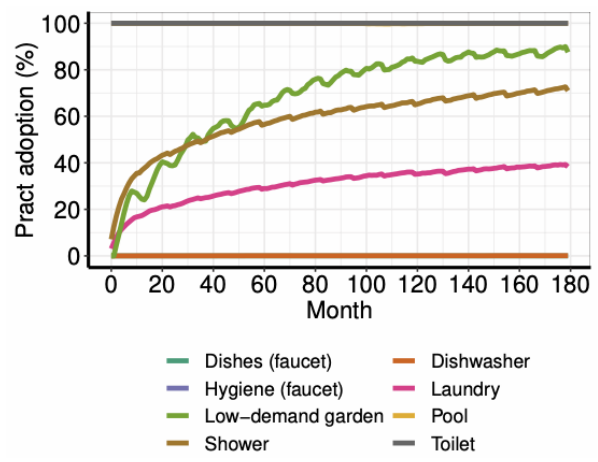
Figure 4. Simulated adoption of technologies in Scenario S1.